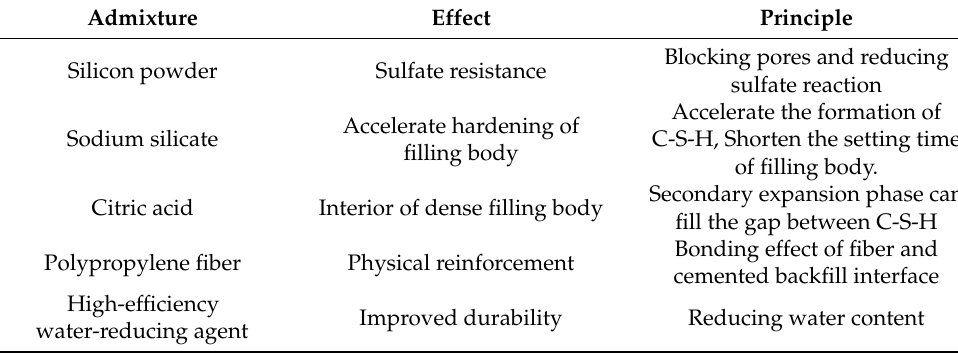
Table 3. Admixture Types and